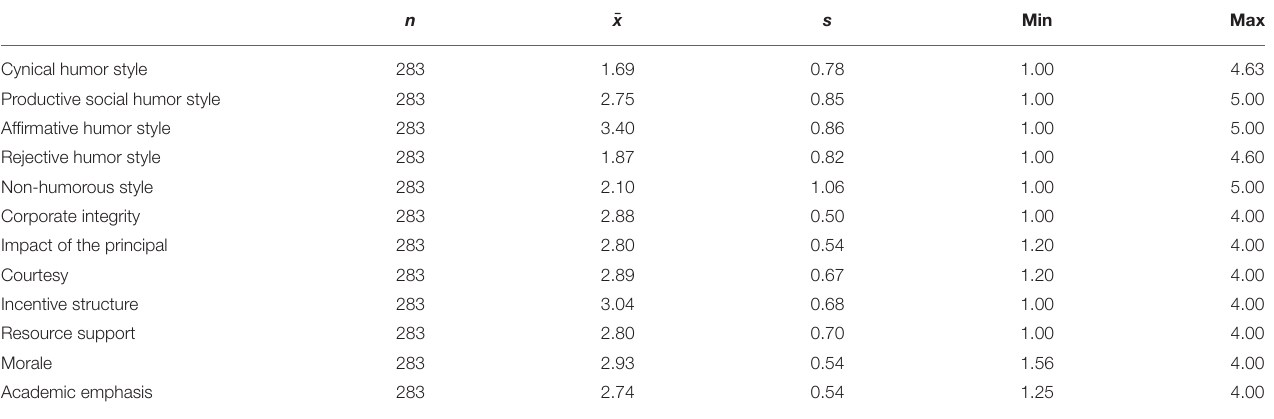
TABLE 3 | Scores of teachers from the humor behavior scale and organizational health inventory ( n =